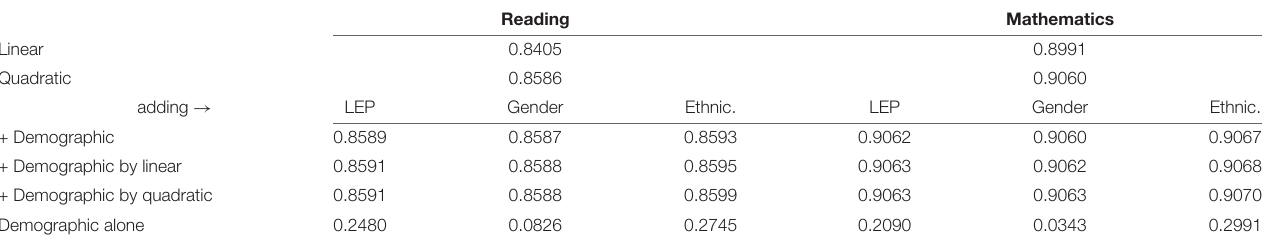
TABLE 4 | R 2 values from regressions between spring MAPs and SBAs when including LEP, gender, and ethnicity. The final line shows the relationship (main effect, without conditioning on MAPs) between LEP, gender, and ethnicity with SBAs (achievement gaps). See Appendix for more information on achievement gap data.